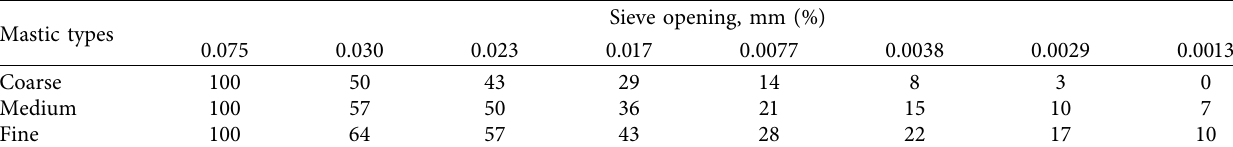
Table 2: Different types of fillers gradation.